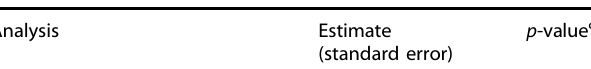
Table 3. Results from all analyses.